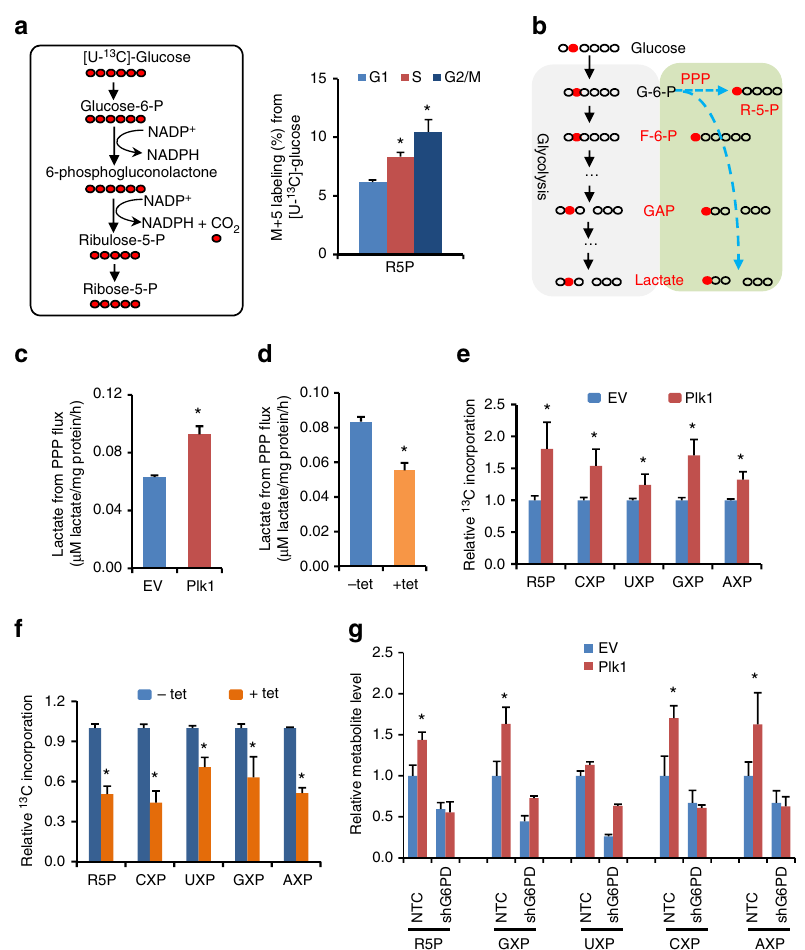
Fig. 2 Plk1 enhances PPP and biosynthesis in cancer cells. a Using [U- 13 C]-labeled glucose, M + 5-labeled R5P produced from PPP was detected by LC-MS. HeLa cells were synchronized by double HU block. When the cells were treated for the second round of HU block for 11 h, i.e., 1 h before releasing, U- 13 C glucose was added into the medium and further culture for 1 h and then harvested for G1 phase cell analysis. For cell samples of S and G2/M phases, after the regular second round of HU block for 12 h, cells were released into fresh HU-free medium and further cultured for 4 and 9 h, respectively, followed by supplementation of U- 13 C glucose and 1 h culture before harvesting cells for analysis. Cells were harvested and 13 C-incorporated R5P was detected by LC- MS. The calculation of % of the m + 5 isotopologue of ribose is % of the sum of isotopologues. b – f The PPP metabolites were detected by NMR. Cells were cultured in medium containing [2- 13 C]- or [U- 13 C]-labeled glucose. The graphic description shows that by using the [2- 13 C]-labeled glucose, NMR measurement could distinguish the lactate produced from PPP and that derived from the general glycolysis ( b ). Lactate derived from the oxidative PPP was calculated by the total lactate multiplied with the ratio of 3- 13 C lactate detected by NMR in Plk1 overexpression ( c ) or knockdown cells ( d ). Using the [U- 13 C]-labeled glucose, R5P and some downstream nucleotides generated from the PPP fl ux were detected by NMR in Plk1 overexpression ( e ) or knockdown cell lines ( f ). To induce Plk1 shRNA expression, cells were grown in the presence of 0.1 μ g/ml doxycycline for 72 h. The calculation of isotopologue of ribose is total intensity of 13 C-labeled ribose moiety. g U- 13 C glucose metabolic fl ux assays were performed in Plk1-overexpressing HeLa cells with G6PD knockdown by NMR. The results were normalized to cell numbers or cell wet weight. Data were represented as the mean ± s.d. or s.e.m. * P < 0.05 as compared to indicated group by two-sided Student ’ s t